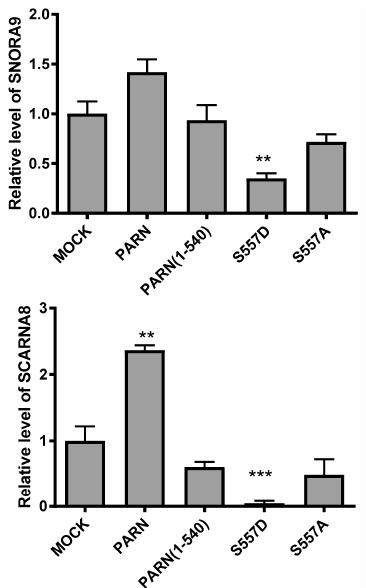
Figure 8. Effect of exogenously expressed wild type (WT) and mutated PARN on the RNA levels of SNORA9 and SCARNA8 in the HEK-293T cells under normal cell culturing conditions by qRT-PCR ( n = 3). PPIA was used as the internal control. ** p < 0.01; *** p <